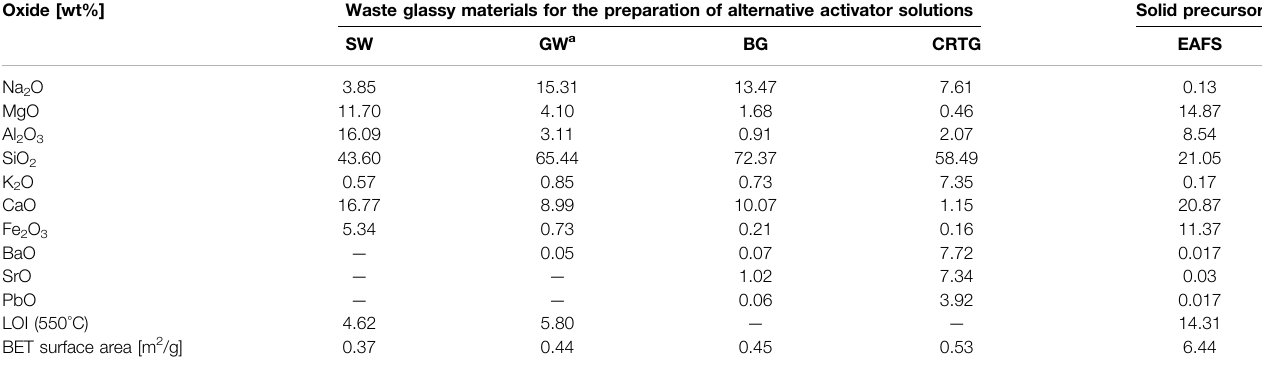
TABLE2| Analysisoftherawmaterialswithrespecttotheirchemicalcomposition,presentedasmasspercentagesinoxideform(wt%,XRF),speci fi csurfacearea,andloss on ignition (LOI). Oxide